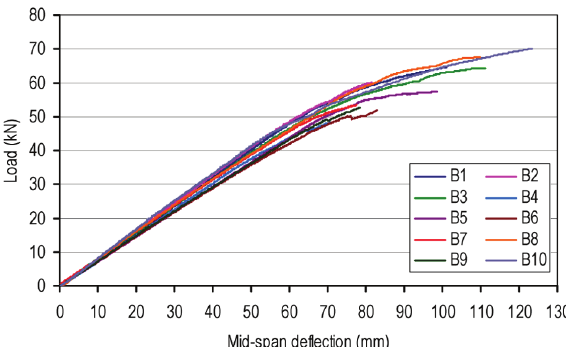
Fig. 5. Load-deflection behaviour for beams reinforced with one CFRP plate (Series B)